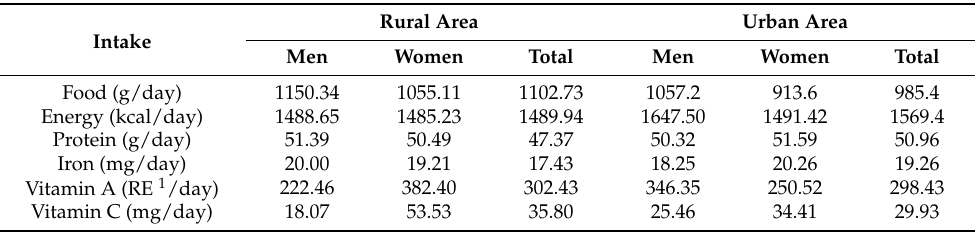
Table 1. Daily food and selected nutrients intake in the studied population of men and women in the rural and urban area of Bogor,